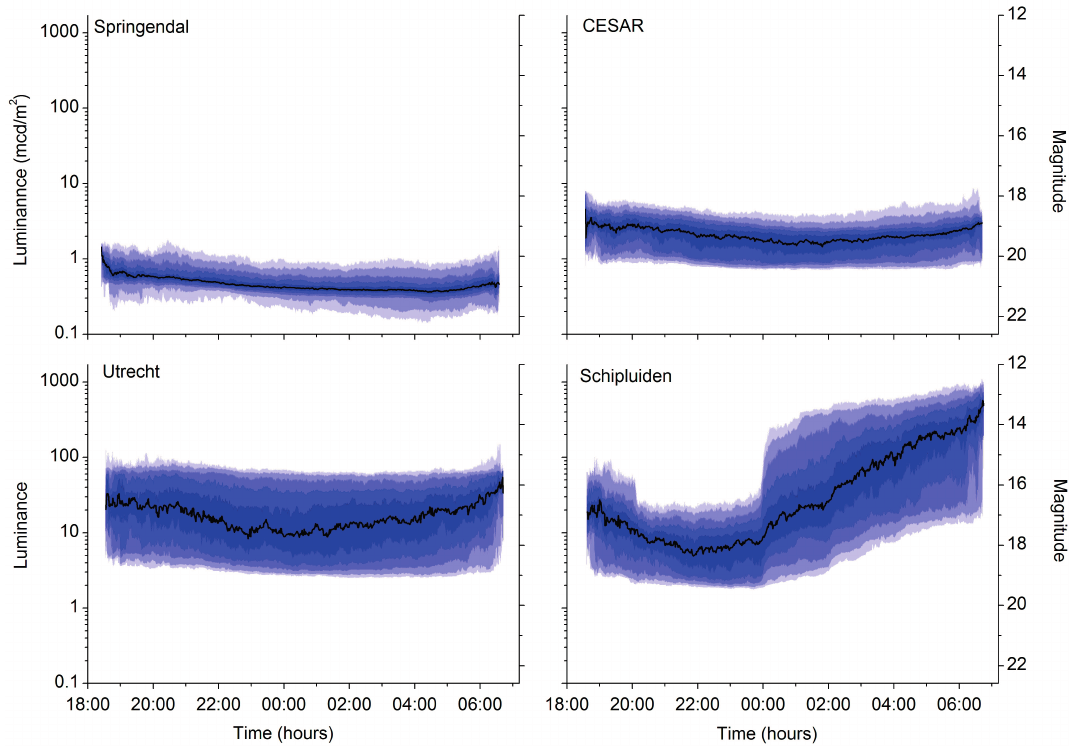
Figure 1. Luminance as function of time at four locations of the MHN. Moonlit nights are excluded, solar elevation is below − 18°. The right axis gives the corresponding magnitude per square arcsecond. The median is indicated by the black line, and the darkest band is limited by the 60 and 40 percentile values. Bands have brighter colours towards smaller percentiles (30, 20, 10 and 5), or towards greater percentiles (70, 80, 90 and 95). Shielding of greenhouses is mandatory until midnight